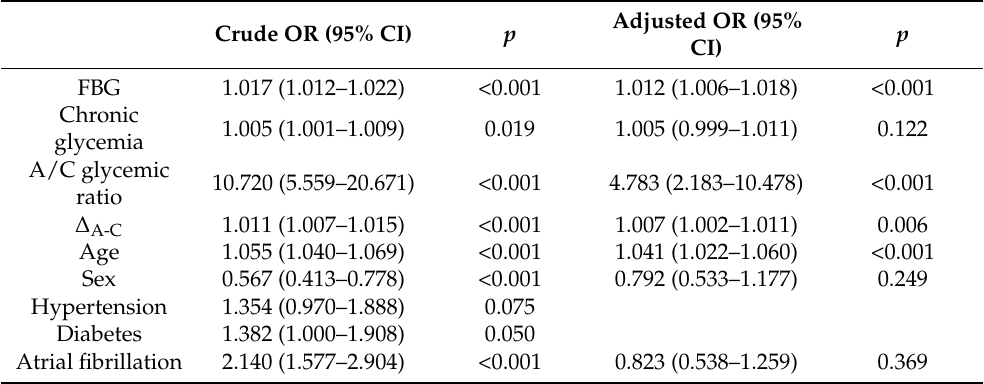
Table 2. Unadjusted and adjusted ORs of glycemia and other baseline characteristics for poor functional